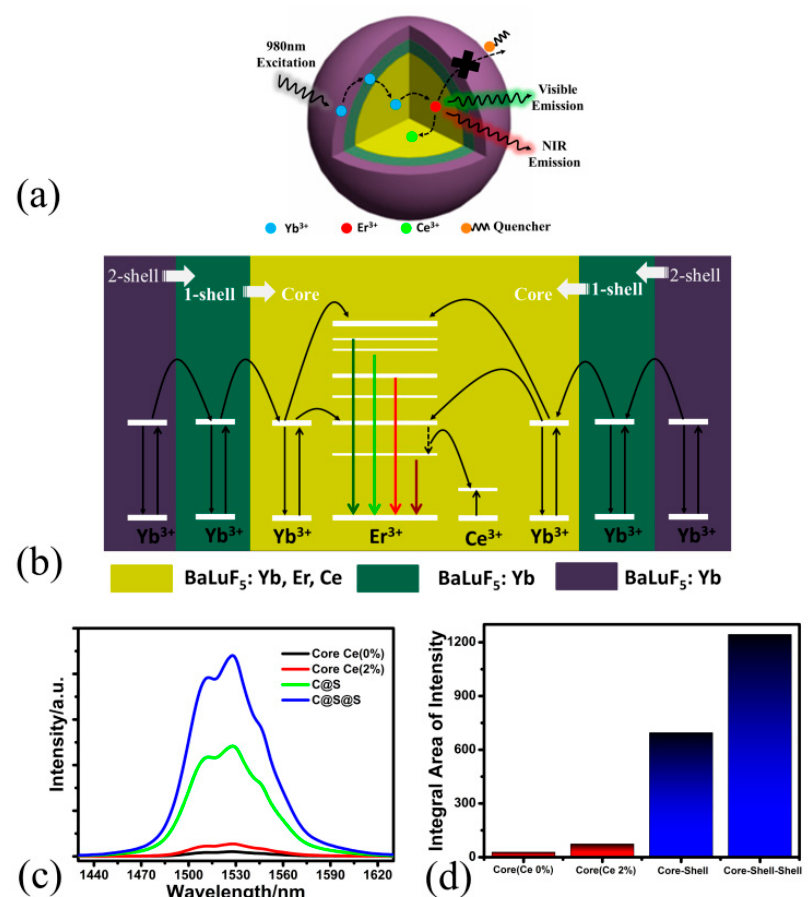
Figure 6. ( a ) Schematic illustration and ( b ) energy transfer mechanisms of BaLuF 5 :18%Yb 3+ ,2%Er 3+ ,2%Ce 3+ @BaLuF 5 :5%Yb 3+ @BaLuF 5 :5%Yb 3+ core-active-shell-active-shell NPs. ( c ) DC emission spectra of BaLuF 5 :18%Yb 3+ ,2%Er 3+ core NPs, BaLuF 5 :18%Yb 3+ ,2%Er 3+ 2%Ce 3+ core NPs, BaLuF 5 :18%Yb 3+ ,2%Er 3+ ,2%Ce 3+ @BaLuF 5 :5%Yb 3+ core-active-shell NPs and BaLuF 5 :18%Yb 3+ ,2%Er 3+ ,2%Ce 3+ @BaLuF 5 :5%Yb 3+ @BaLuF 5 :5%Yb 3+ core-active-shell-active-shell NPs. ( d ) Intensity enhancement of DC emission in all the above NPs.